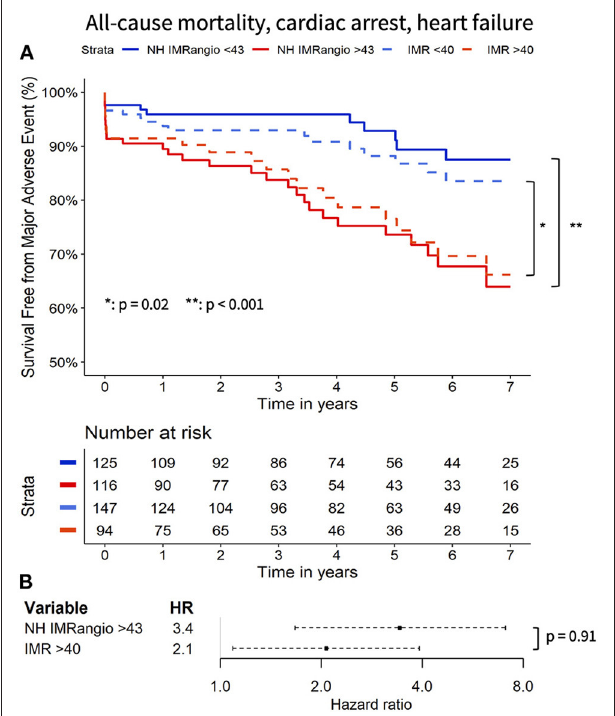
FIGURE 3 | Kaplan Meier curves of freedom from cardiac mortality, resuscitated cardiac arrest, new heart failure diagnosis with high vs. low (i) NH IMR angio and (ii) IMR (A) . Forrest plot displaying the hazard ratio of high (i) NH IMR angio and (ii) IMR (B) . HR, hazard ratio; IMR, index of microcirculatory resistance; NH IMR angio , non-hyperaemic IMR angio